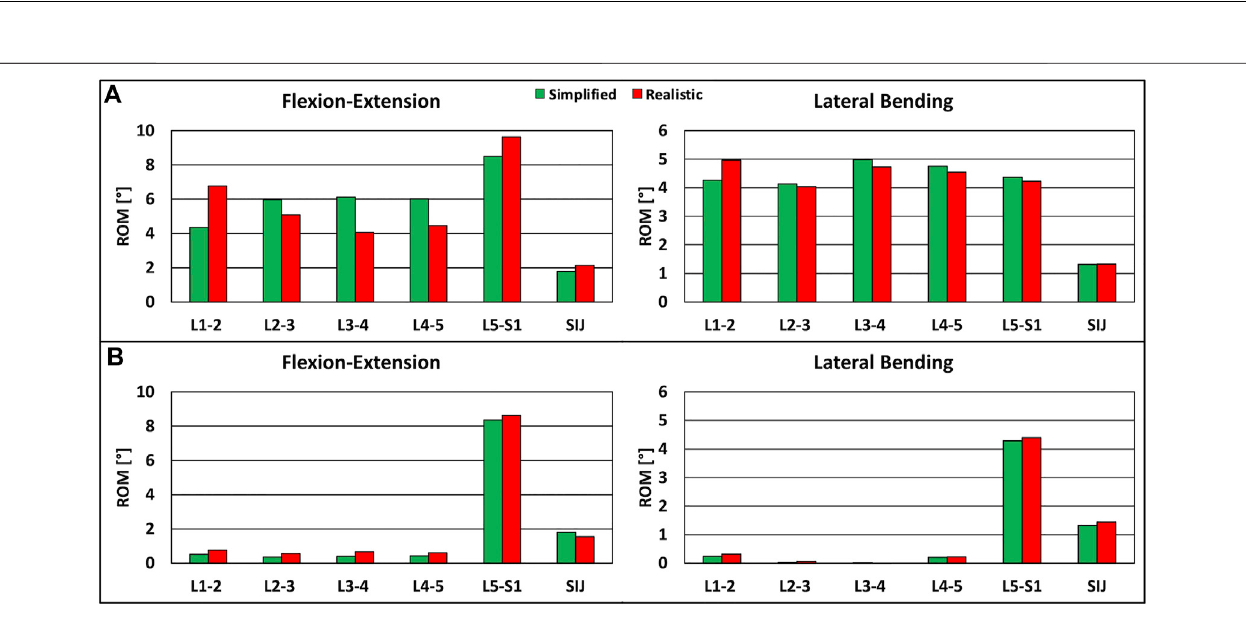
Frontiers in Bioengineering and Biotechnology |